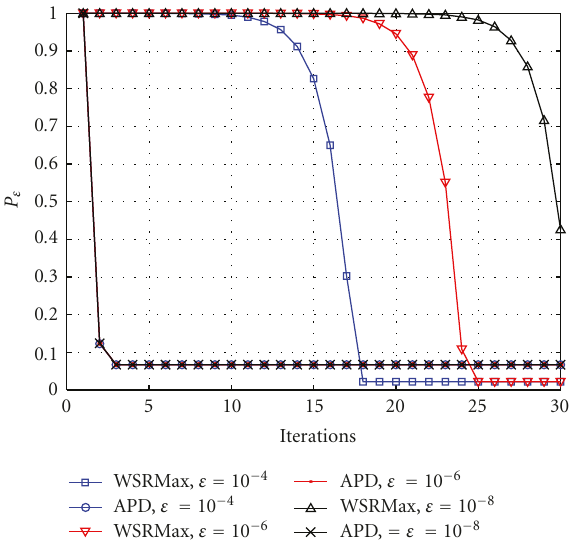
Figure 5: Data rate region with 2 users and 8 subcarriers.